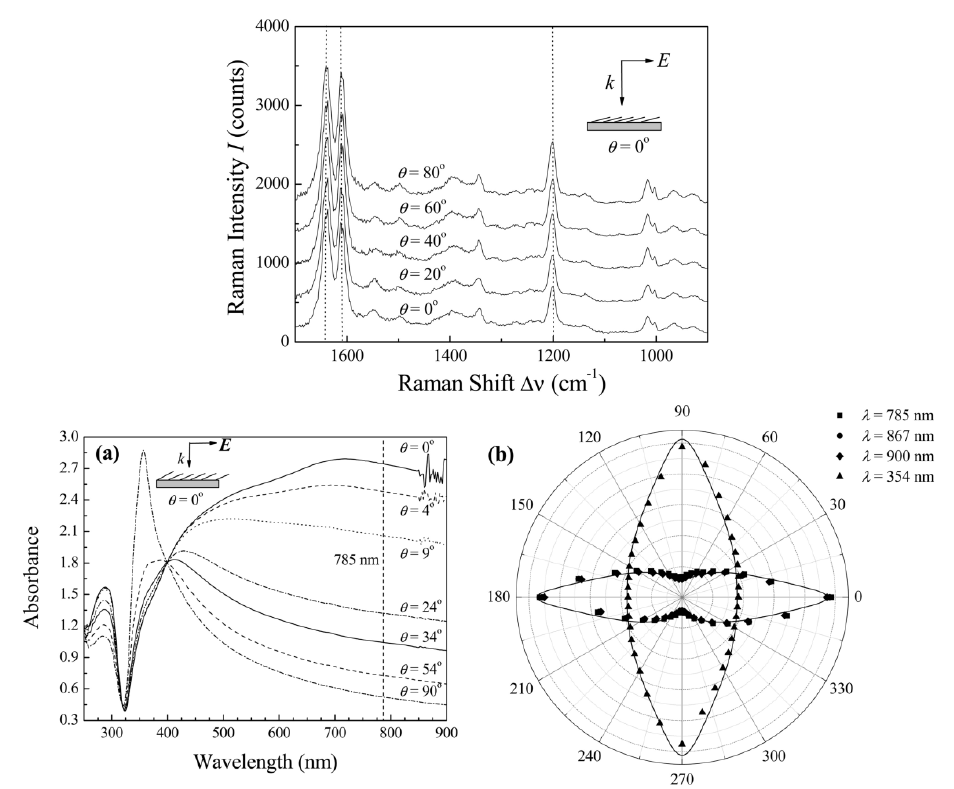
Figure 14. ( a ): Polarized SERS spectra of trans-1,2-bis(4-pyridyl)-ethene (BPE) on Ag nanorod substrates as a function of the incoming polarization angle measured in a backscattering geometry. ( b ): Polarized UV/Vis/NIR absorption spectra. Cross-section of the NR array is schematically depicted in the inset (inclination angle of the nanorods was ~ 71° with respect to the surface normal). Both diagrams show the p-polarization direction with the incident polarization almost parallel to the major long axis of the nanorods. The maximum SERS intensity was observed in the polarization direction perpendicular to the long axis of the Ag nanorods, while the UV/Vis absorbance was strongly polarized along the direction of the long axis of the NR array. Adapted with permission from [97]. Copyright